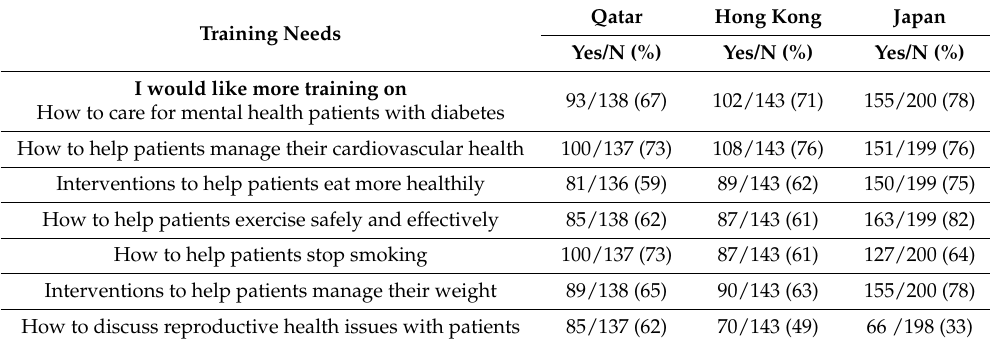
Table 4. Respondents’ perceived training